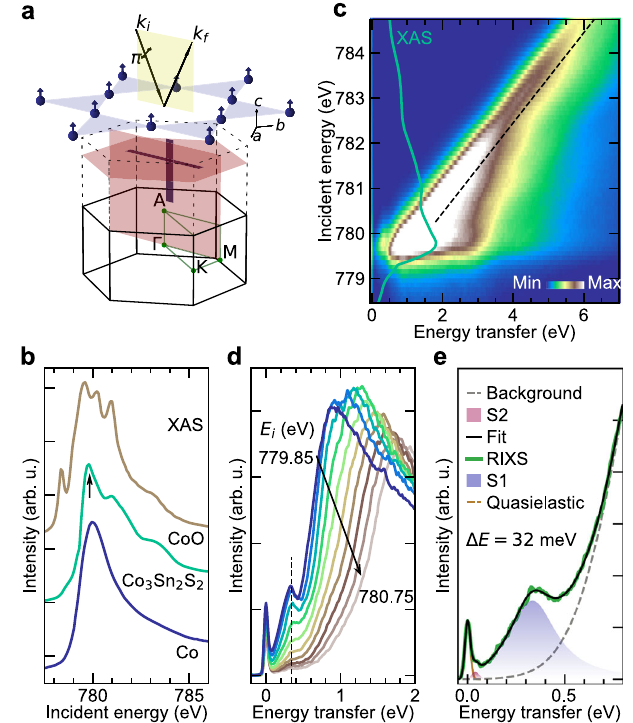
Fig. 1 | Spectroscopic signatures of correlated states in Co 3 Sn 2 S 2 . a Two dimensional (2D) FM Kagomé unit formed by Co atoms in Co 3 Sn 2 S 2 with the RIXS scattering geometry. The magnetic easy axis is along the crystallographic c -direc- tion. RIXS measurements presented have been collected at the points shown by horizontally and vertically shaded strips parallel to Γ – M and Γ – A directions, respectively. b ComparisonofmultipletfeaturesobservedintheCo L 3 -edgeXASof CoO, Co 3 Sn 2 S 2 and Cometalshifted vertically. The arrowshows the E i usedfor the momentum and temperature dependent RIXS measurements. c RIXS map with E i varied across the Co L 3 -edge on Co 3 Sn 2 S 2 at 23 K at ( − 0.05,1.60). The dashed line followsthemain fl uorescencefeature.Co L 3 -edgeXASspectrumofCo 3 Sn 2 S 2 (green solid line) is superimposed on top of the RIXS map. d RIXS line cuts from c above the Co L 3 -XAS threshold in steps of Δ E i =0.1 eV. The vertical dashedline shows the E i -independent feature. e Representative low-energy RIXS spectrum at (0.1,1.25) with aggregated least-square fi t of different low-energy peak pro fi les and a high energy background. As discussed in the text, S1 and S2 primarily represent Stoner excitations from spin-polarised fl at